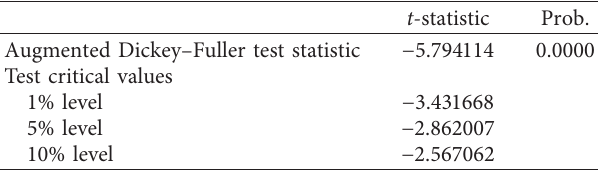
Table 6: Unit root test of sequence VPIN for IH dominant contract.